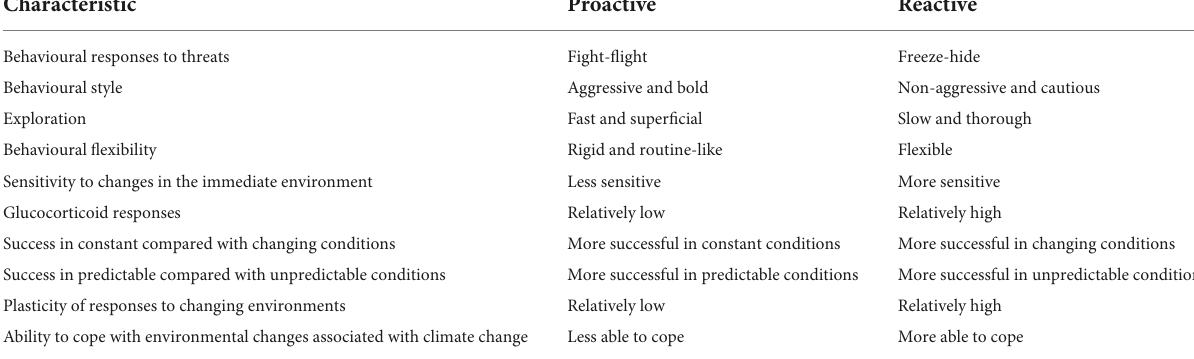
TABLE 4 Proposed characteristics of animals with proactive and reactive personalities [adapted from Cockrem